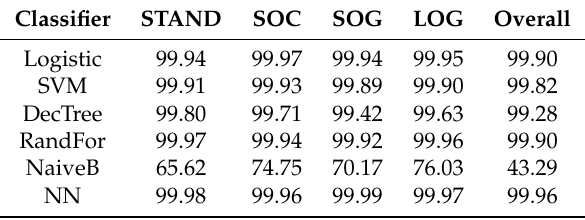
Table 1. Class-wise accuracy of algorithms (%). Logistic: Logistic Regression, SVM: Support Vector Machines, DecTree: Decision Tree, RandFor: Random Forest, NaiveB: Naive Bayes, NN: Neural